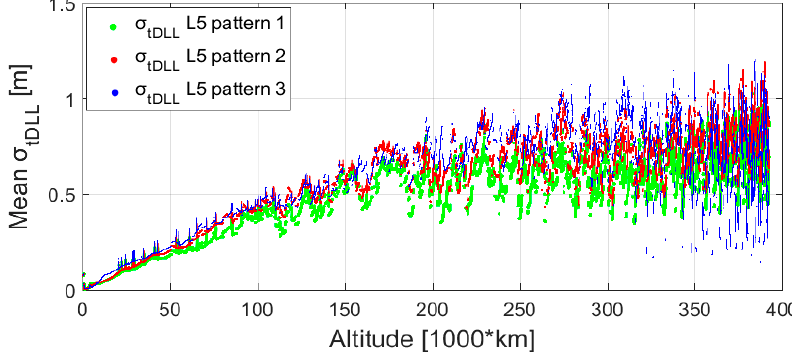
Figure 27. Mean code tracking thermal noise range error for the assumed MTO. The thermal noise range error is computed for each available PRN and the mean is plotted.